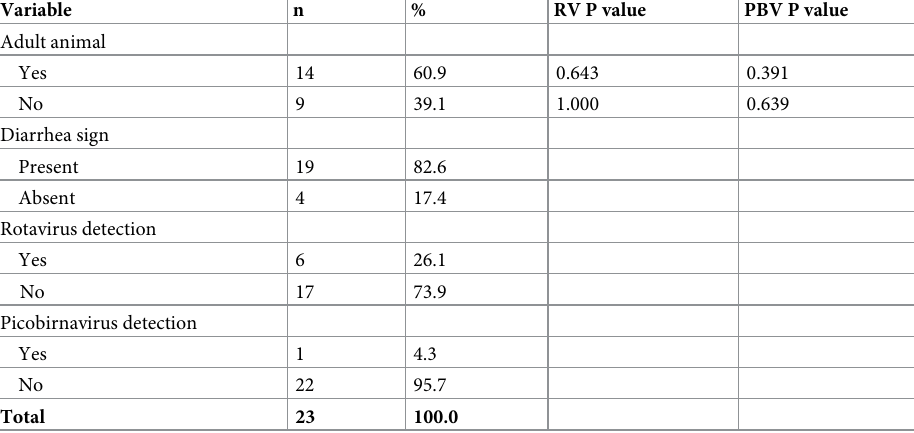
Table 4. Distribution of animals’ age, diarrhea sign, rotavirus and picobirnavirus detection in birds attended in the Veterinarian Hospital of Castanhal,